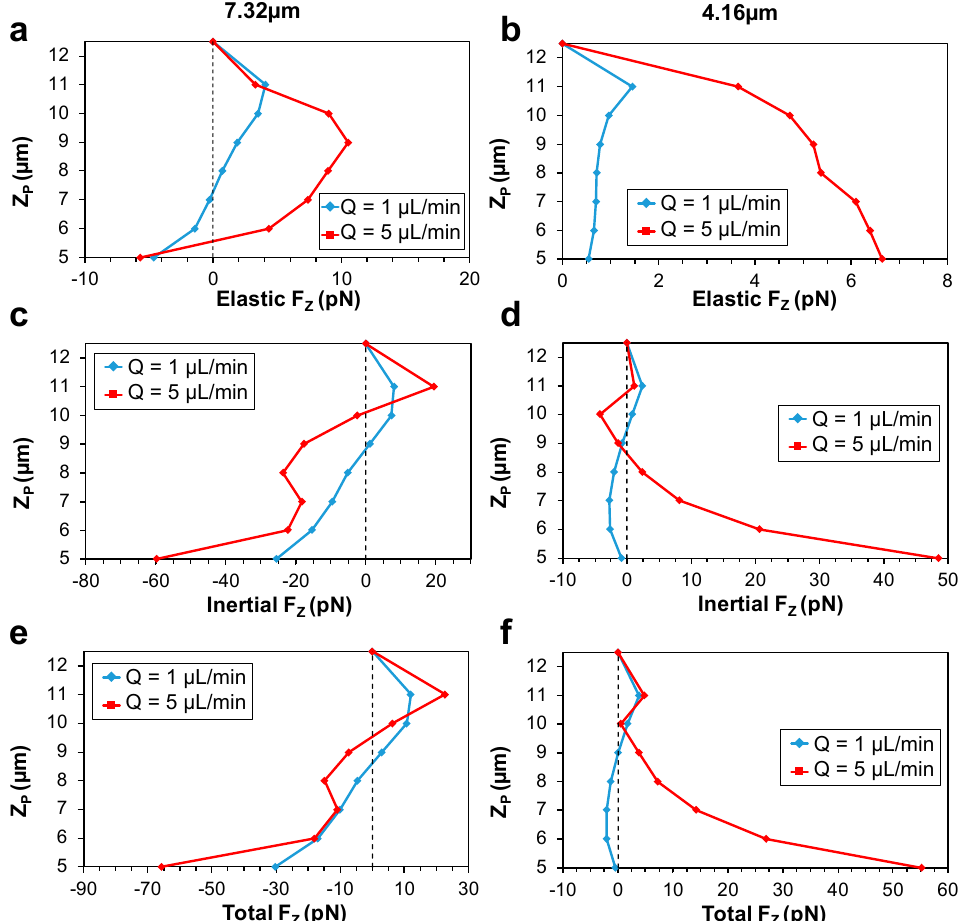
Figure 7. Vertical force (F Z ) distribution along the Z-midline of the channel. Elastic force profile for the ( a ) 7.32 µm and ( b ) 4.16 µm diameter particles at Q = 1 µL/min ( Wi = 3.6) and Q = 5 µL/min ( Wi = 18). Inertial force profiles for the ( c ) 7.32 µm and ( d ) 4.16 µm diameter particles at the two flowrates. Total force profiles for the ( e ) 7.32 µm and ( f ) 4.16 µm diameter particles at the two flowrates.